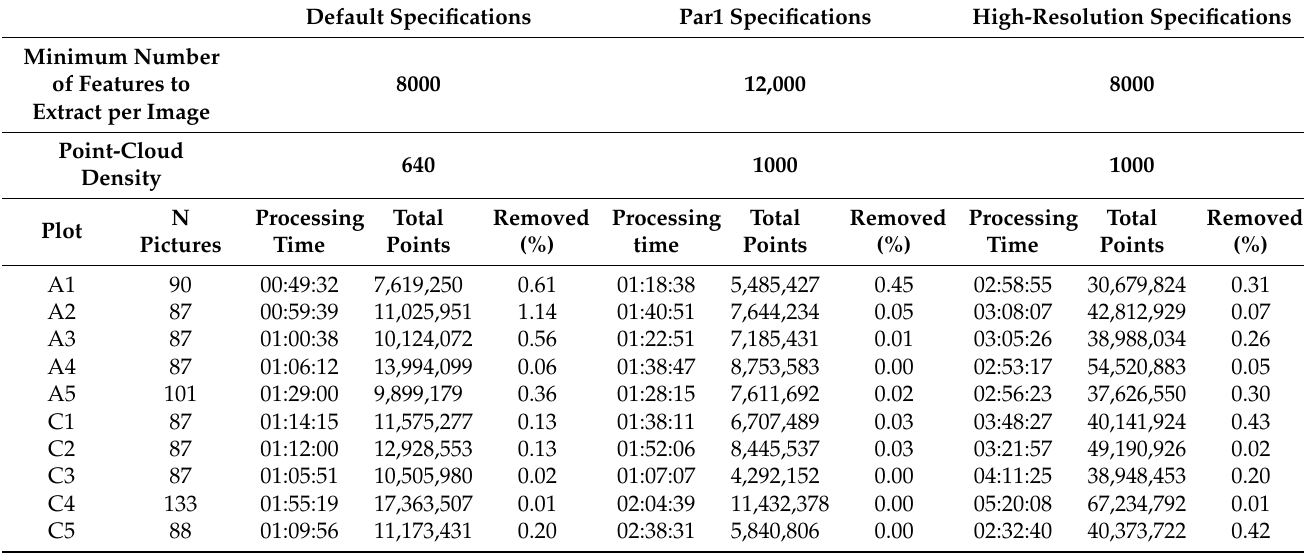
Table A1. Cloud-processing specifications and point-cloud characteristics.